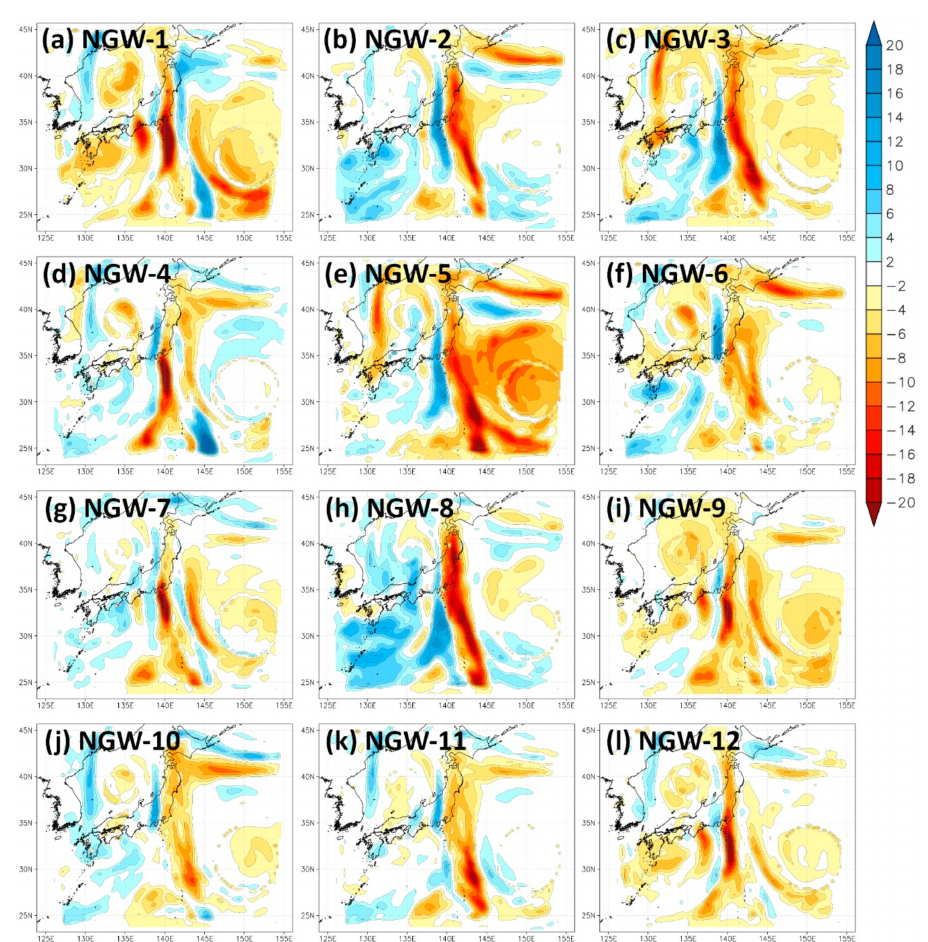
Figure 14. Di ff erence in PWC at 18 UTC 9 September between each NGW simulation and the hindcast. Result of ( a ) NGW-1, ( b ) NGW-2, ( c ) NGW-3, ( d ) NGW-4, ( e ) NGW-5, ( f ) NGW-6, ( g ) NGW-7, ( h )